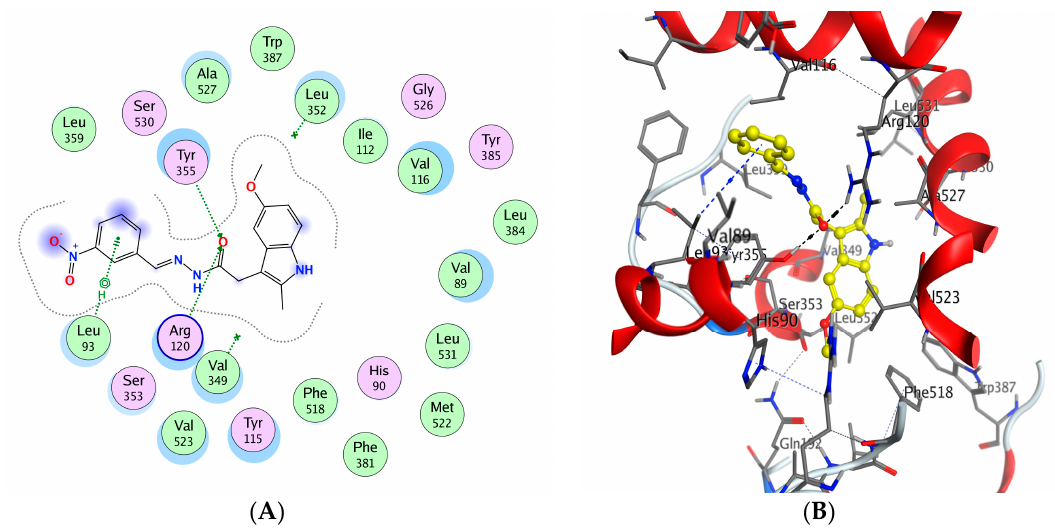
Figure 5. Compound S3 in the binding site of COX-2 (PDB: 4COX). ( A , B ) represents the 2D and 3D docking view of compound S3 with binding site of COX-2. In 2D, green dashed line represents hydrogen bonding; green dashed line represents pi-H bonding; residues which are colored light green, represents hydrophobic interactions. In 3D, black dashed line represents hydrogen bonding; blue dashed line represents pi-H bonding. Molecules 2018 , 23 , x FOR PEER REVIEW